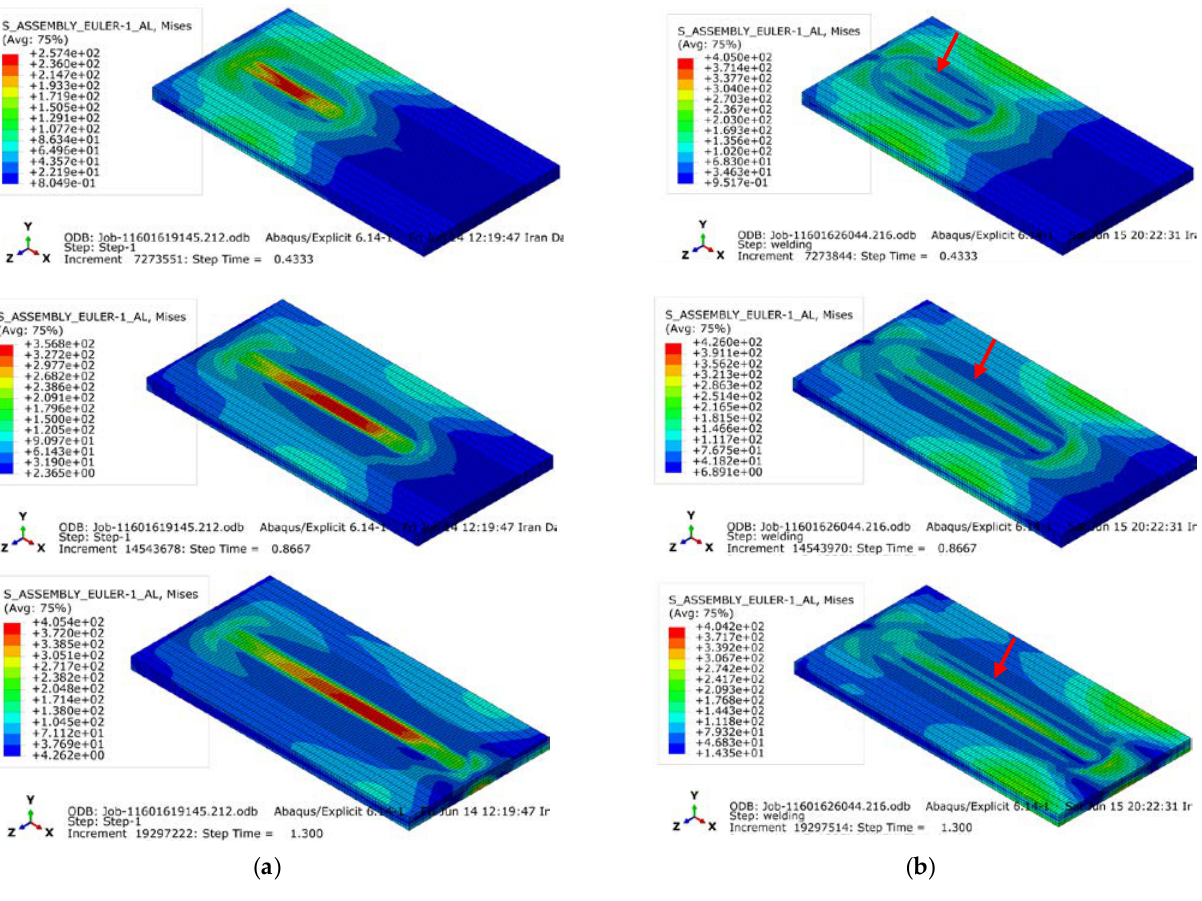
Figure 9. The distribution of the stress at different welding step times ( a ) without tilt angle ( b ) with tilt angle. Figure 10 indicates the cross-sectional view of the stress distribution for the finite element models. As can be seen, at the center of the welding both models show an almost similar behavior. As the distance from the welding center line in the model in which the tilt angle of 1.5° increases, a more compressive stress behavior is observed.